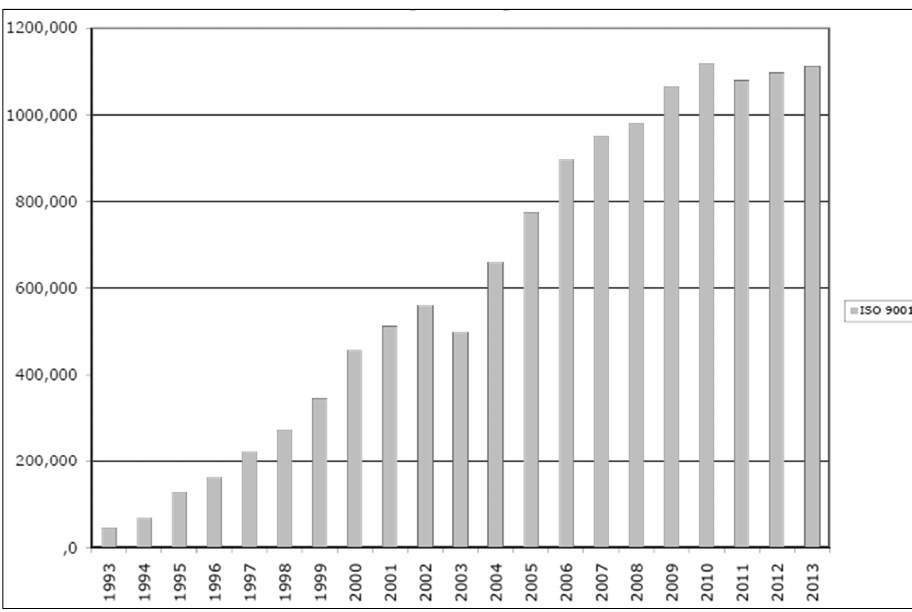
Figure 2 – ISO 9001 Certified Organizations Survey